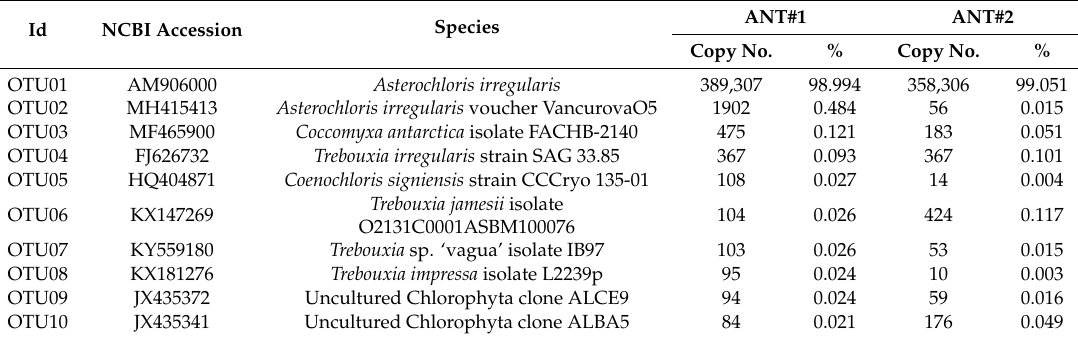
Table 2. Photobiont species list of two Antarctic Cladonia borealis samples analyzed by amplicon sequencing of the ITS